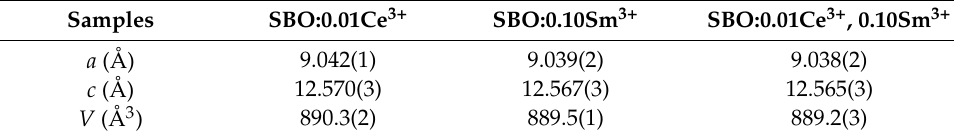
Table 2. Calculated lattice parameters of doped